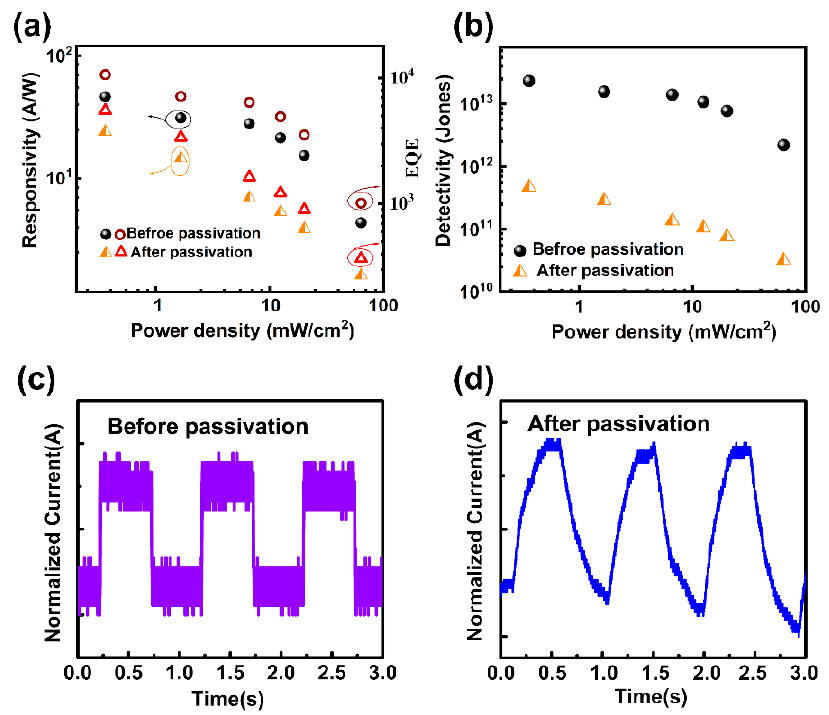
Figure 4. The ( a ) responsivity, EQE, and ( b ) detectivity of the detector under different laser power densities at 8 V before and after passivation. The time-dependent response of the photodetector ( c ) before and ( d ) after passivation at 8 V. Table 1. Comparison of the performance parameters for low-dimensional GaAs